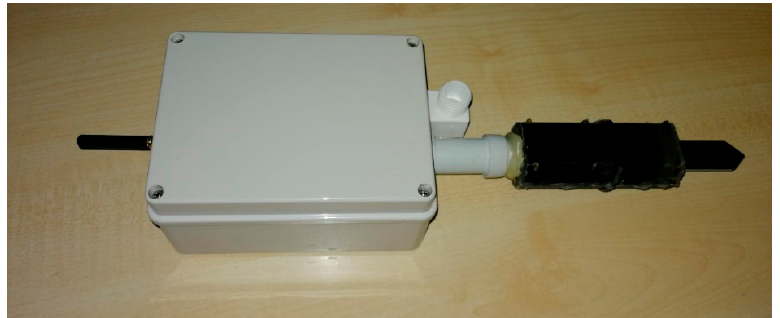
Figure 3. The final version of the Plant Node.